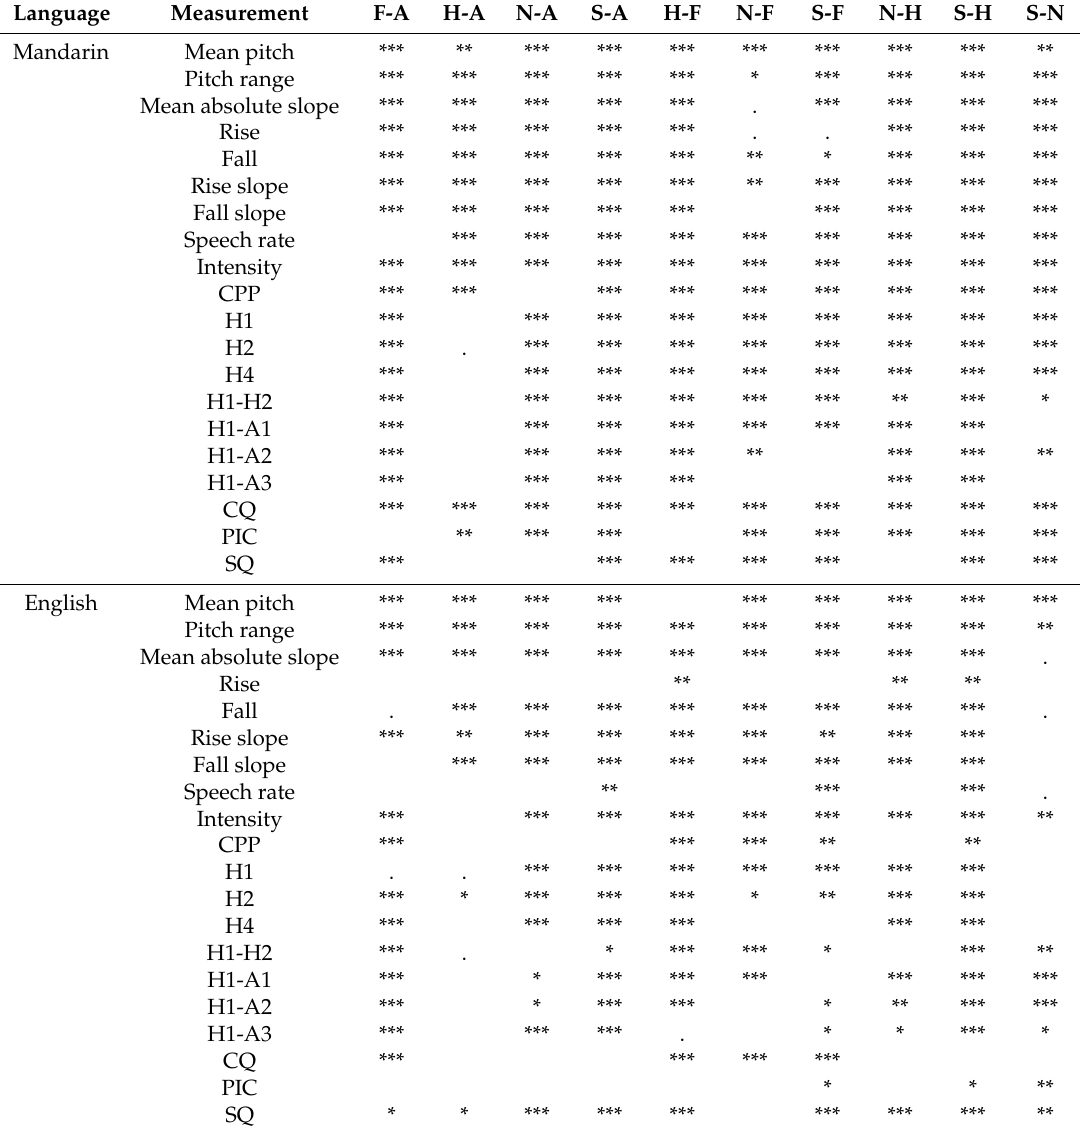
Table 3. Results of multiple comparison analysis for each cue between emotions (A: anger; F: fear; H: happiness; N: neutral; S: